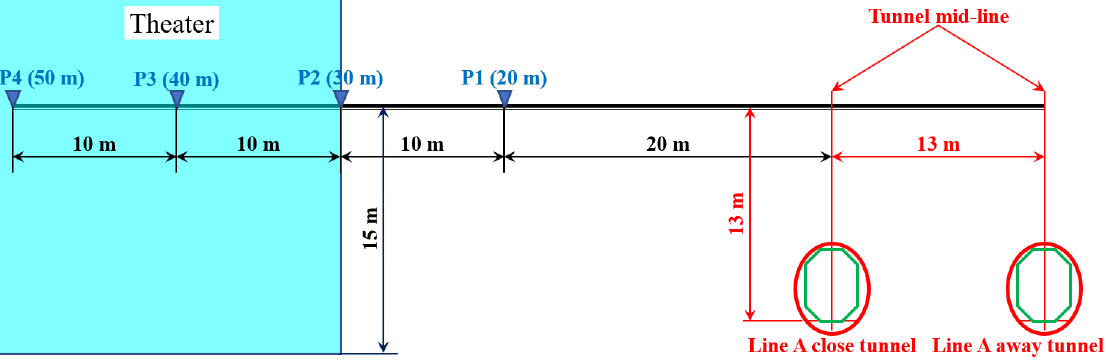
Figure 5. Tunnel wall 1/3 octave frequency division vibration acceleration level of Line A and Line